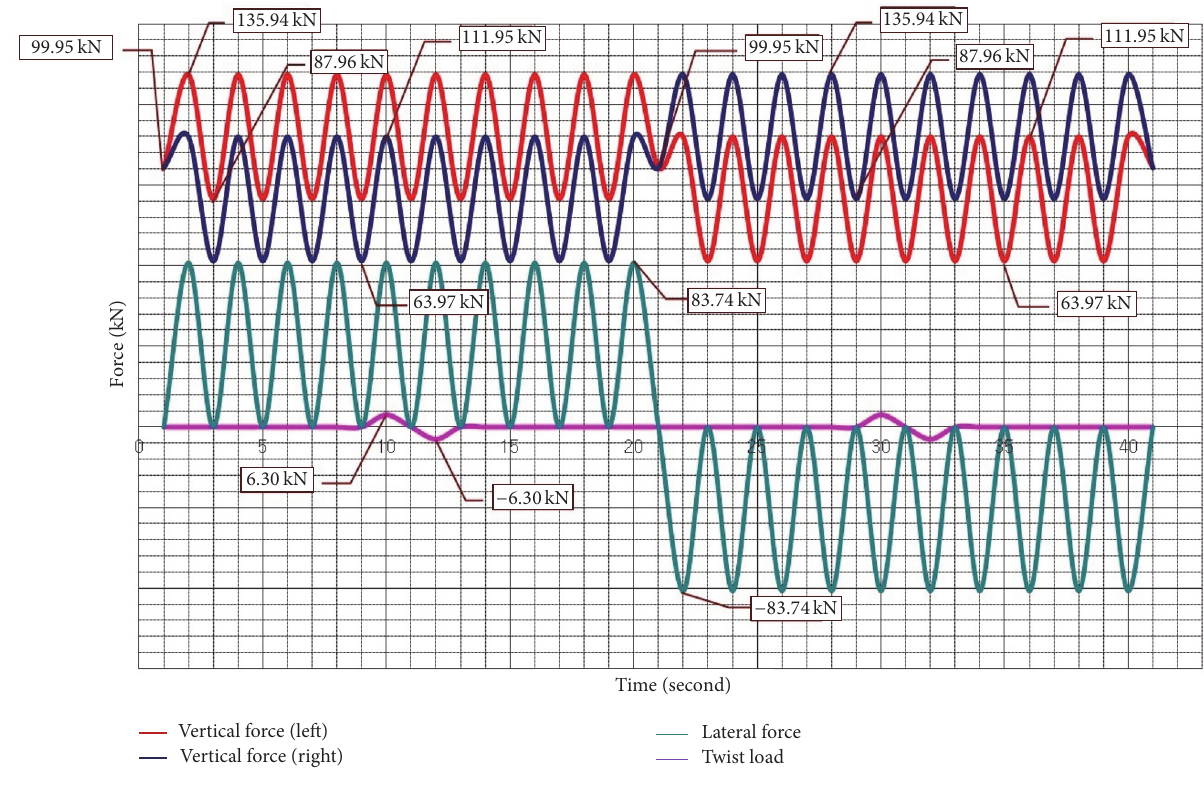
Figure 8: Load history of fatigue test in step 1.